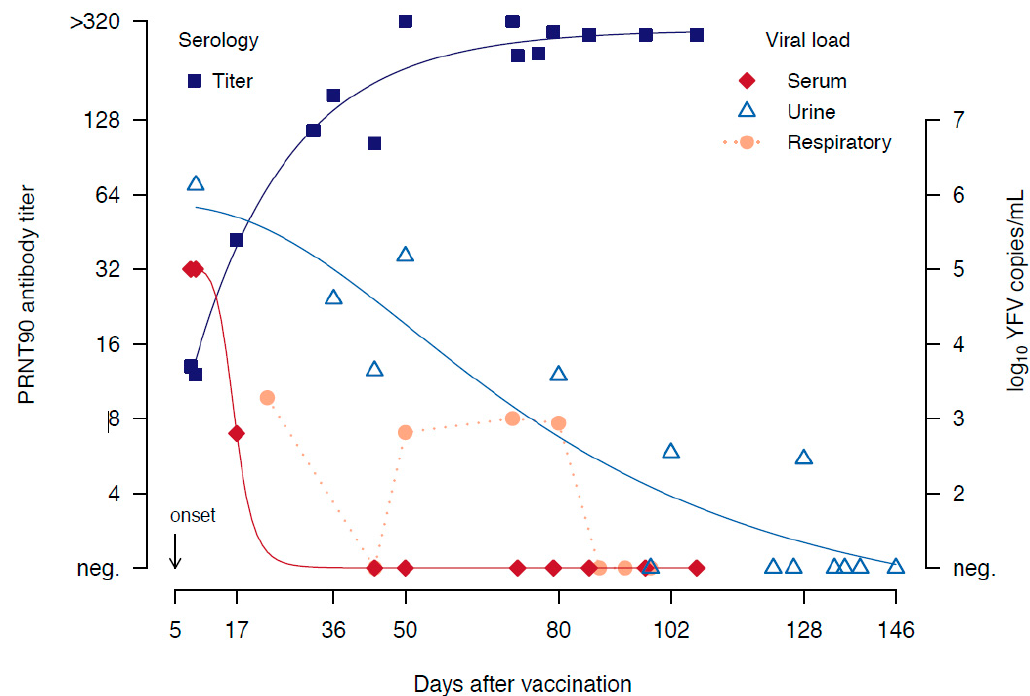
Figure 1. Timeline of yellow fever neutralizing antibody titers and yellow fever viral load observed in serum, urine, and respiratory samples (bronchoalvelar lavage, tracheal secretion). Regression lines indicate a general trend.